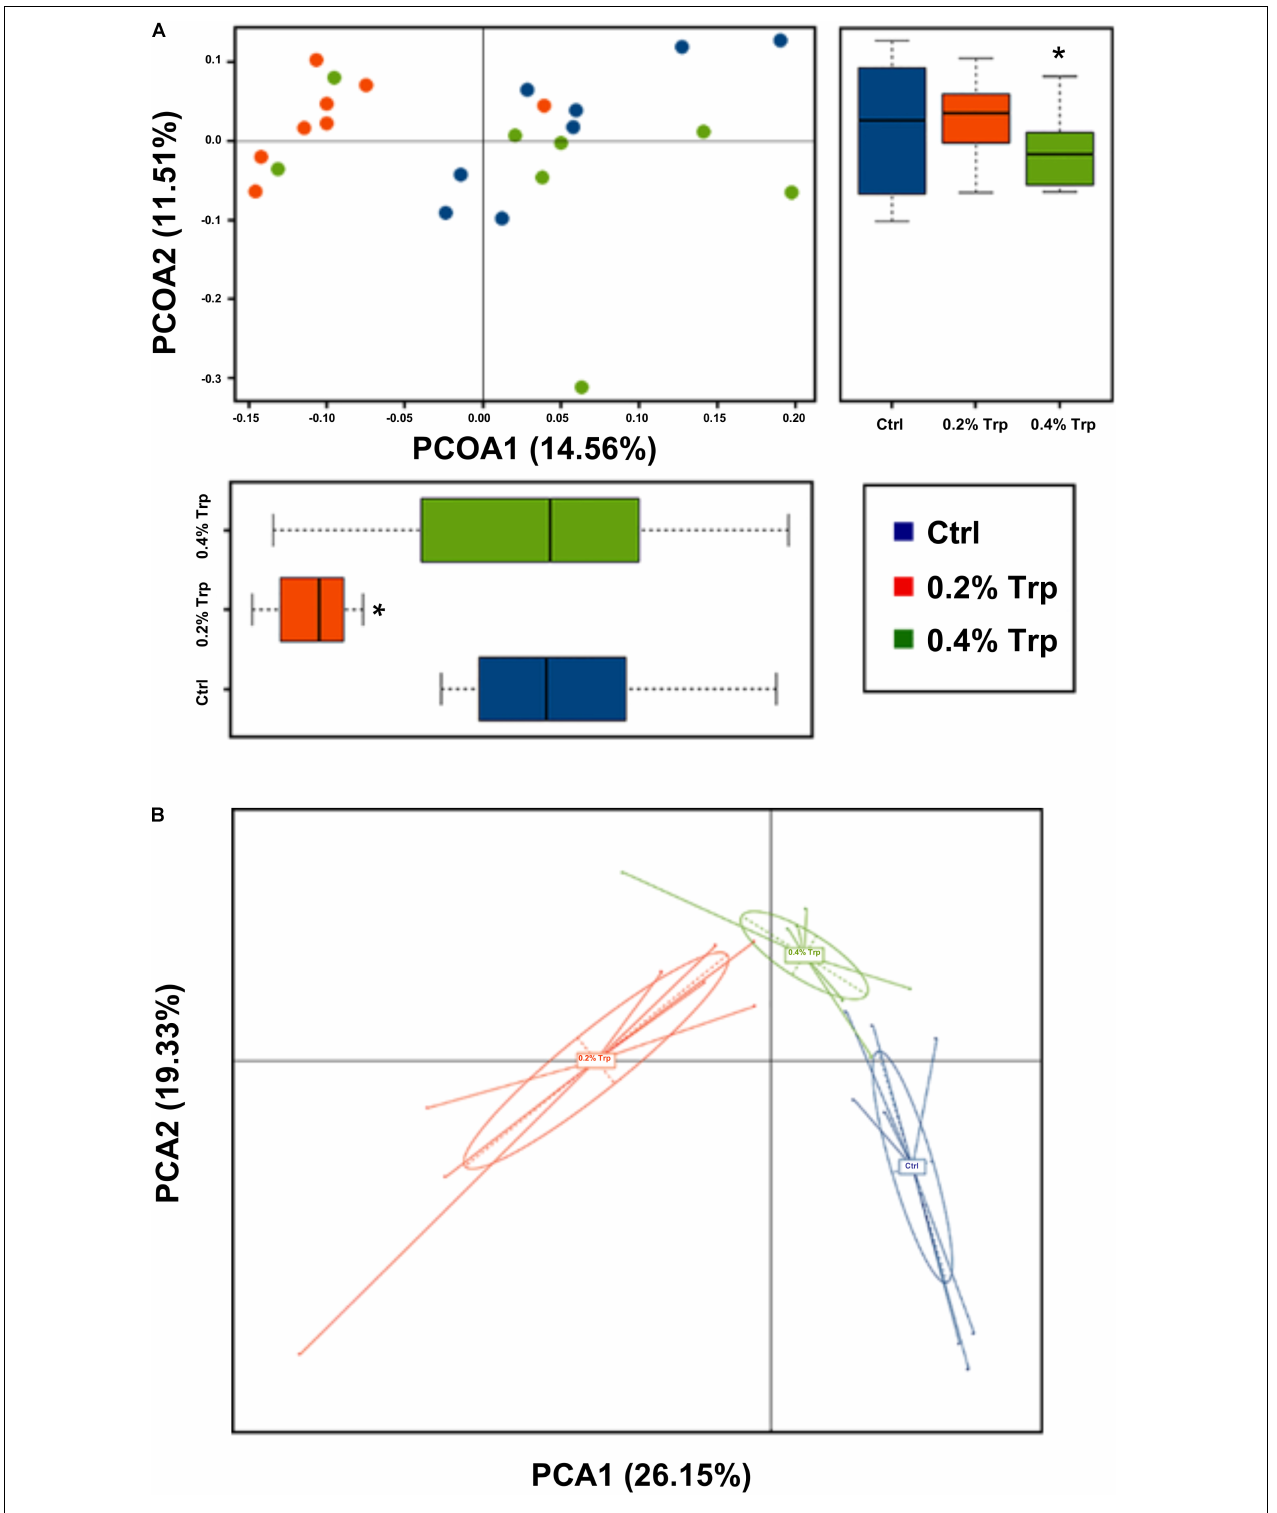
FIGURE 2 | Dietary Trp supplementation altered the beta diversity and overall composition of the microbiota in the cecum. (A) The beta diversity of bacteria community in each group, the horizontal and vertical axis scale indicates relative distances (based on the unweighted unifrac distances). PCoA1 and PCoA2 represent the potential factors (Trp supplementation) that caused a microbial composition shift of the cecal samples. Asterisk indicates a statistically significant difference ( P < 0.05). (B) Effects of Trp on the overall composition of the microbiota at the genus level. Principal component analysis (PCA) was based on the OTUs.